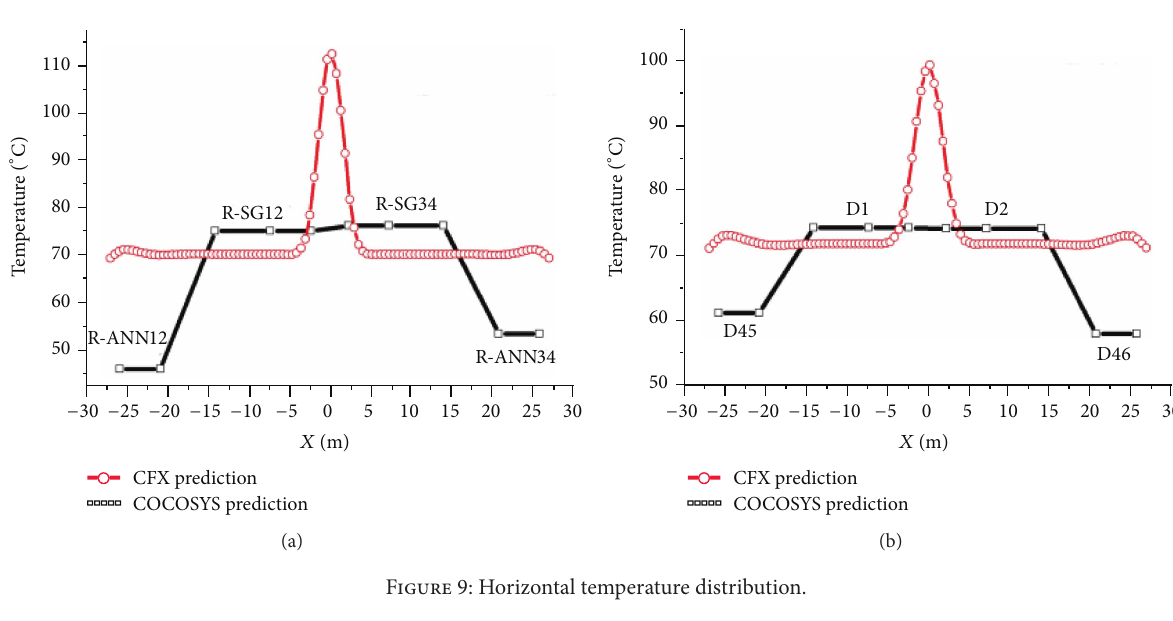
Figure 9: Horizontal temperature